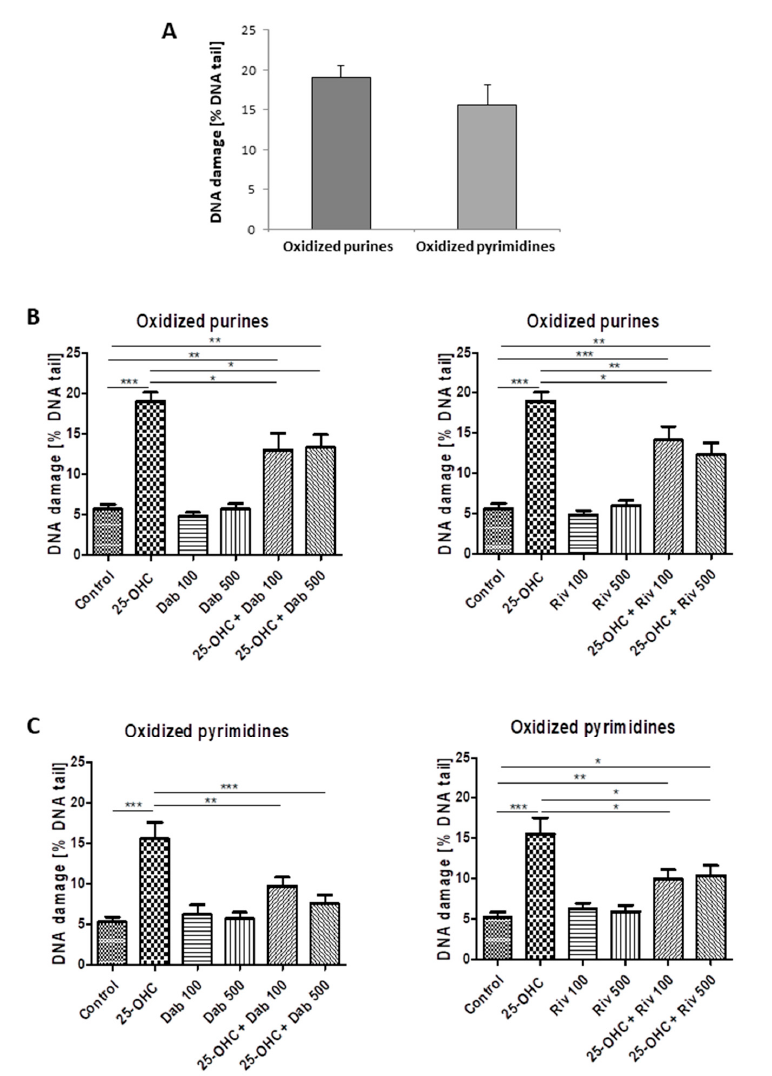
Figure 2. The level of DNA pyrimidine and purine oxidation in HUVECs (analysis by alkaline comet assay using endonuclease III (Nth)) or human 8 oxoguanine DNA glycosylase (hOOG1) was induced by 25-hydroxycholesterol (10 µ g / mL) ( A ). The repair of DNA damage in cells was induced by ( B ) dabigatran (100 ng / mL and 500 ng / mL) and ( C ) rivaroxaban (100 ng / mL and 500 ng / mL). Each experiment